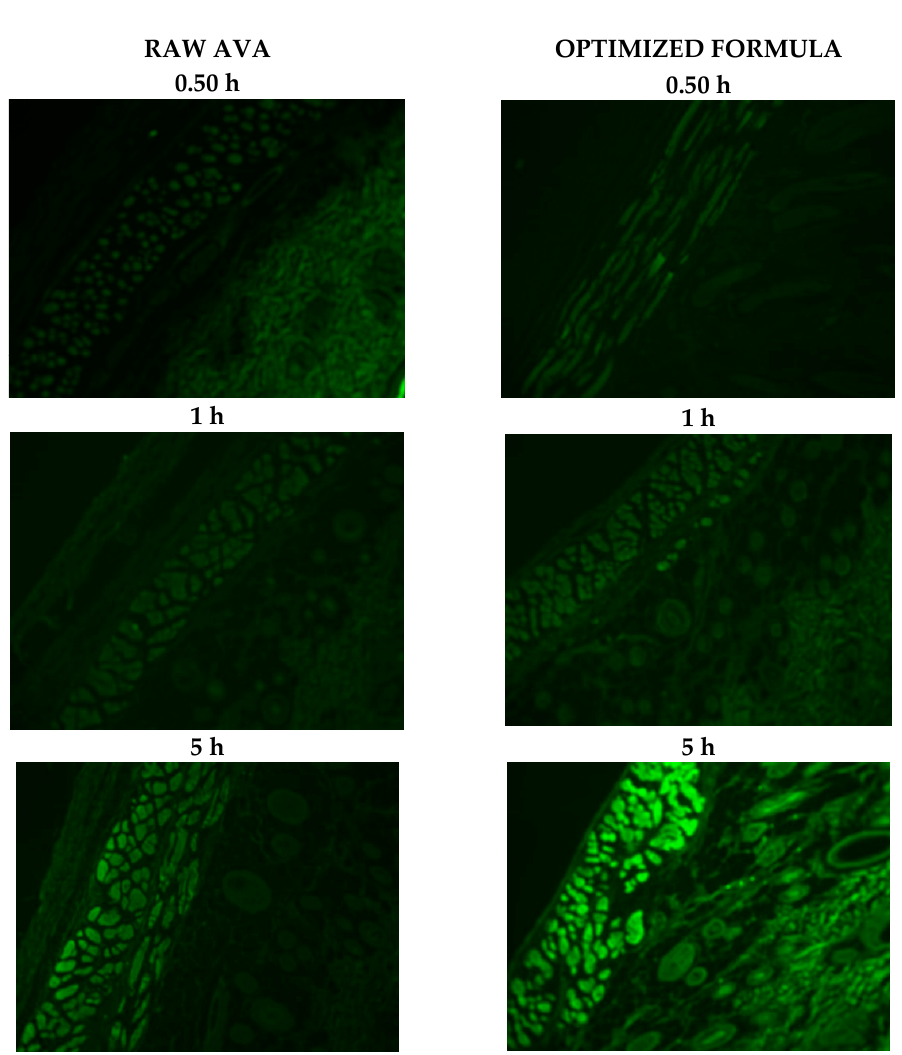
Figure 4. Fluorescence laser microscope images for transdermal application of raw FITC- and optimized formula FITC-loaded films after 0.50, 1, and 5 h (magnification 400 × g ). Table 5. Pharmacokinetic parameters after transdermal application of a single dose (20 mg/kg) of the optimized AVA-MM-loaded transdermal film compared with raw avanafil-loaded film. Parameter Unit